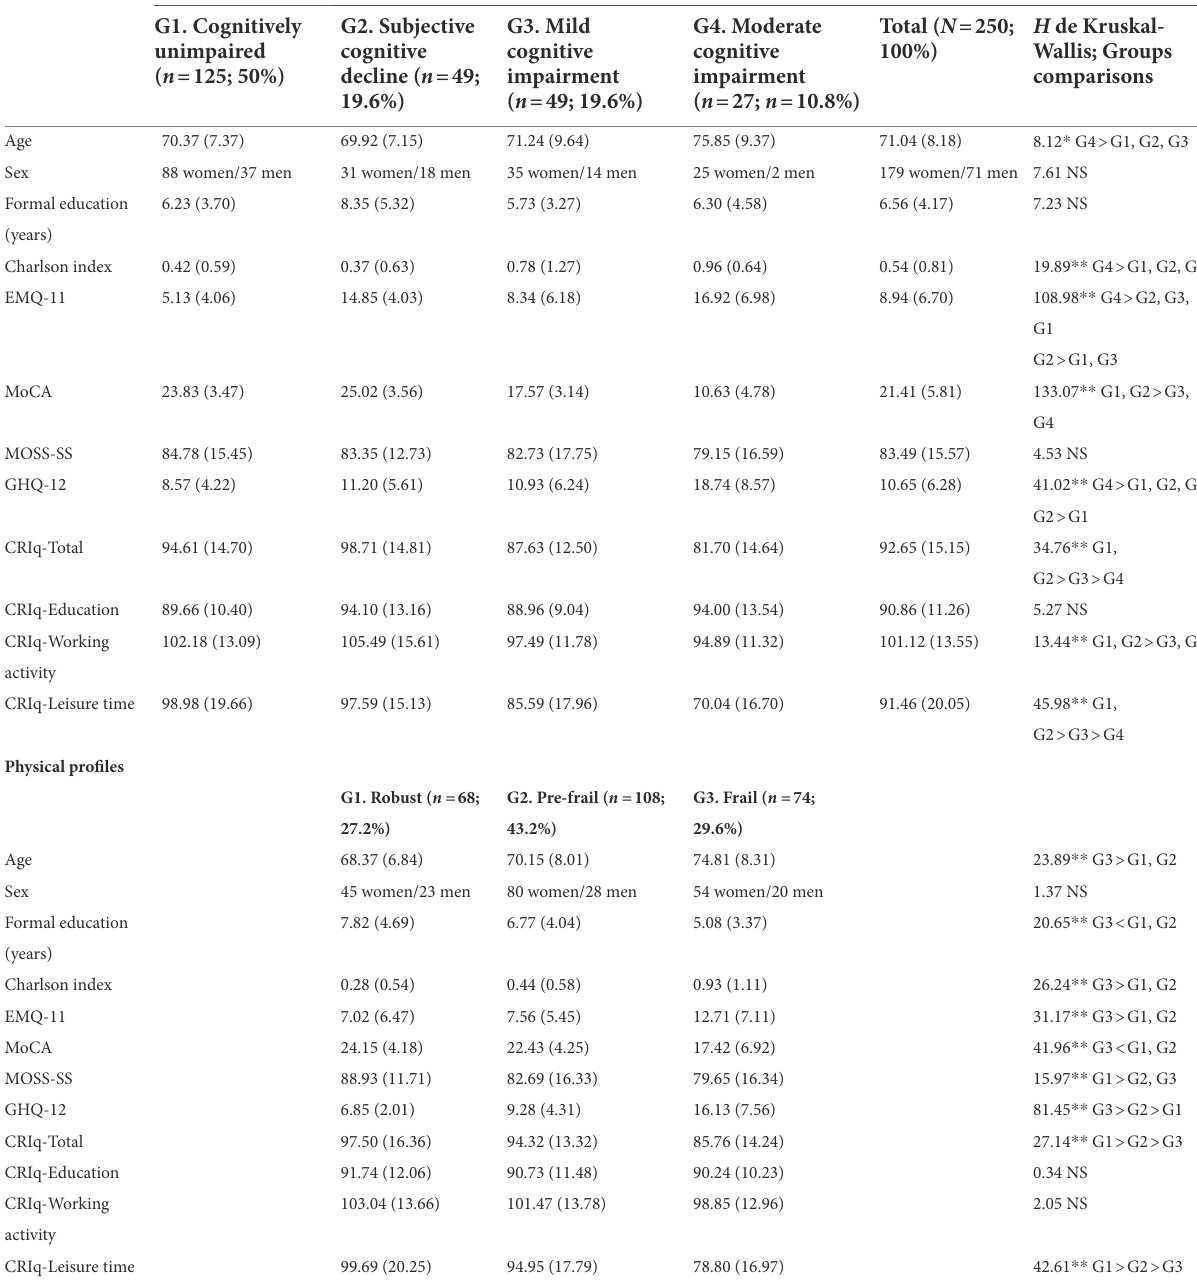
TABLE 1 Socio-demographic, cognitive and physical profiles. Variables Cognitive profiles (all